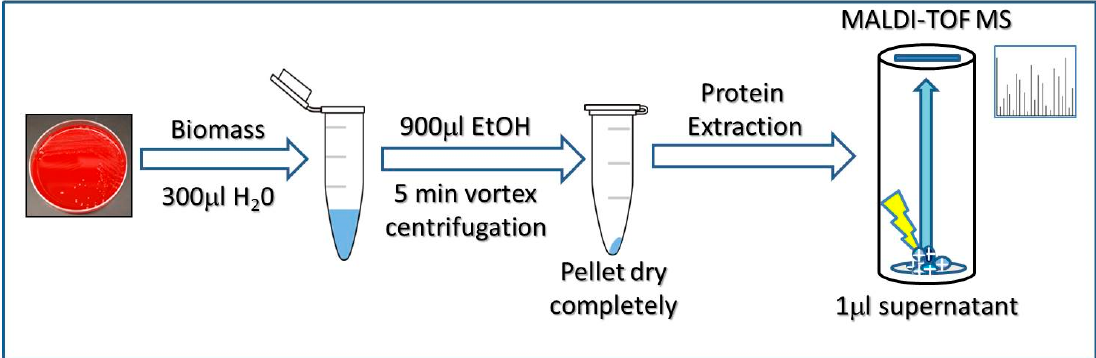
Figure 1. Workflow of the sample preparation method used in this study to obtain proteins from Cryptococcus spp. isolates for their identification by MALDI-TOF MS.